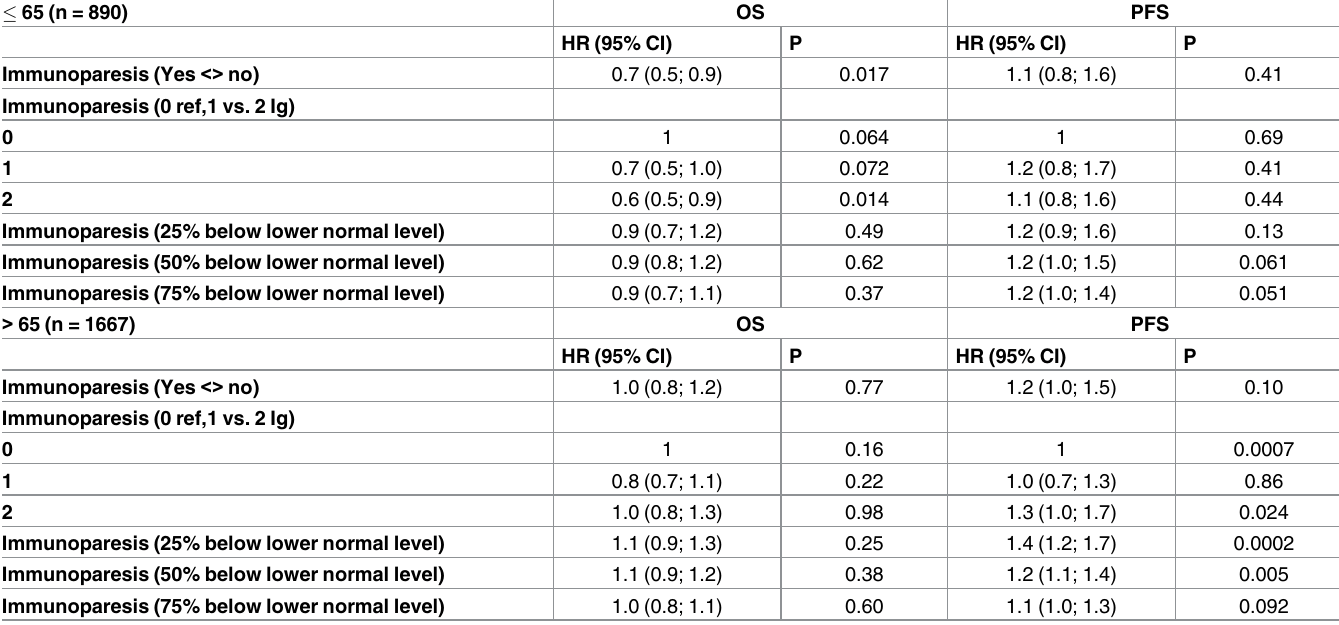
Table 5. Immunoparesis and association to OS and PFS in different age